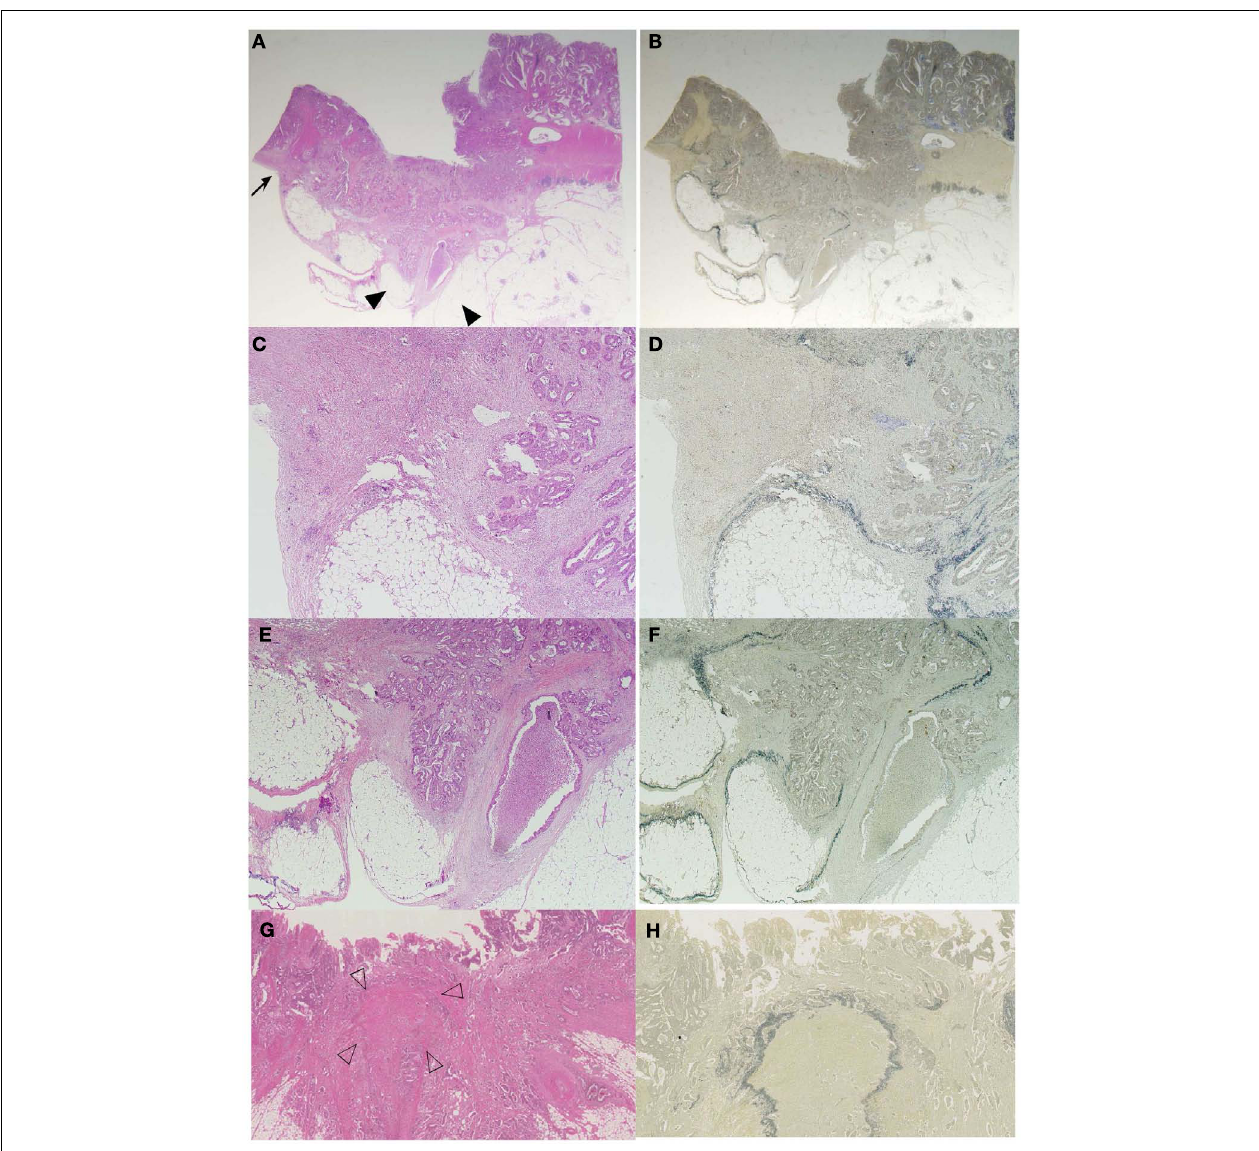
(arrow head) in a colorectal cancer specimen.The tumor had deeply invaded the region near the serosal surface, and prominent fibroinflammation was visible in the area, identical to the macroscopic findings (C,E) . ELI is also seen in the area with macroscopic findings (D,F) . In some cases, prominent fibrosis with a non-cellular matrix component forms a fibrotic focus (G) . Using elastica staining we detect fibrotic focus just beneath the peritoneal elastic lamina (H)